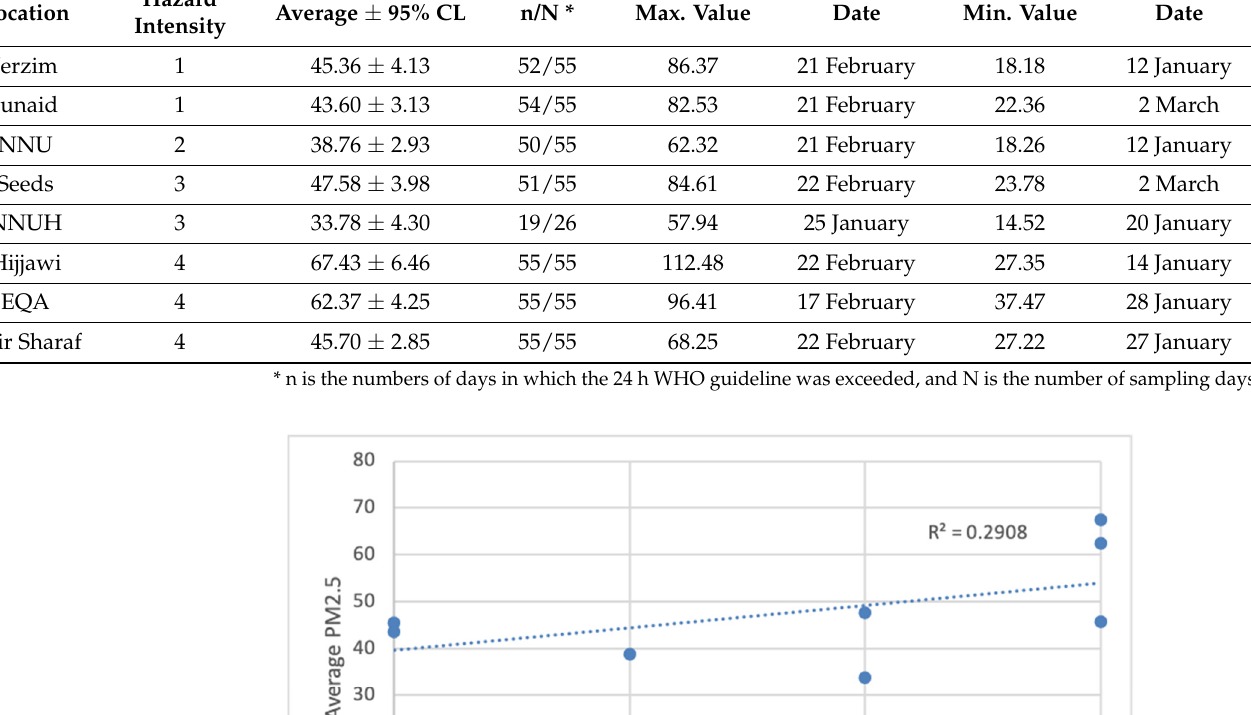
µ g/m 3 ) and hazard 2.5 (in